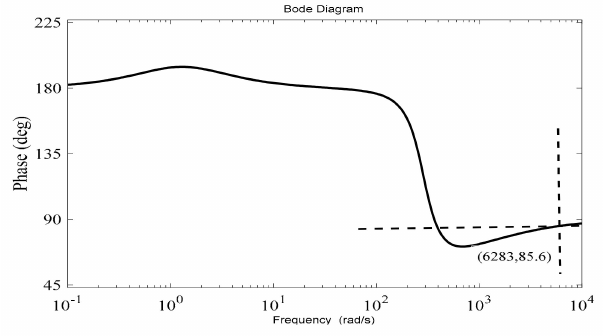
Figure 8. Phase–frequency diagram of F